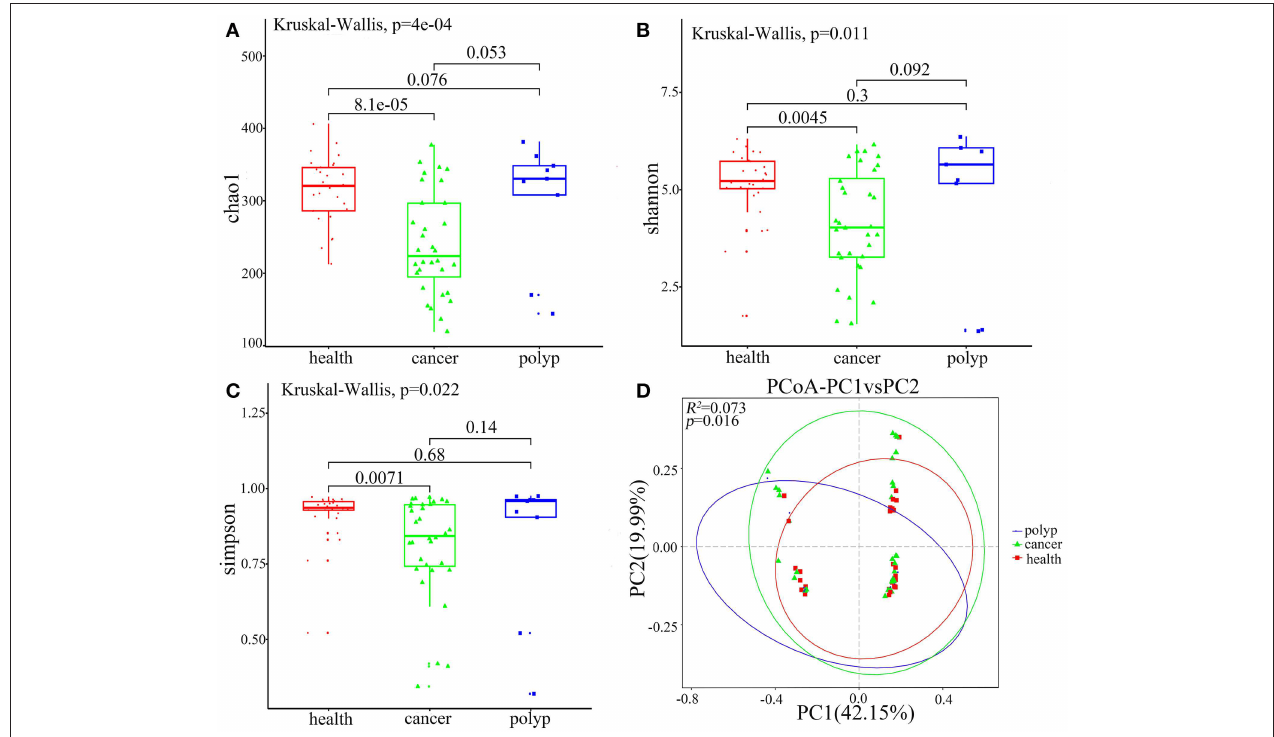
FIGURE 2 | Alpha and beta diversity for the microbial community of samples from the throat cancer patients, vocal cord polyp patients, and normal control group. (A–C) Alpha-diversity analysis with different parameters. Chao1 (A) , Shannon (B) , and Simpson’s reciprocal index (C) . (D) Principal coordinate analysis (PCoA) plots of the unweighted UniFrac distance matrix. Each symbol represents a sample. Green squares represent healthy control patients, blue triangles represent patients with throat cancer, and red circles represent patients with vocal cord polyp. The associated differences are explained in parentheses on the axes. PC1 explained 42.15% of total variation in observed variation, and PC2 explained 19.99% of the remaining